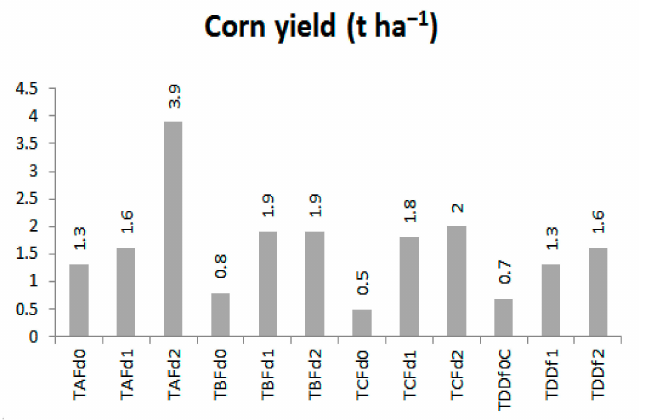
Figure 11. Corn yield 2018 per